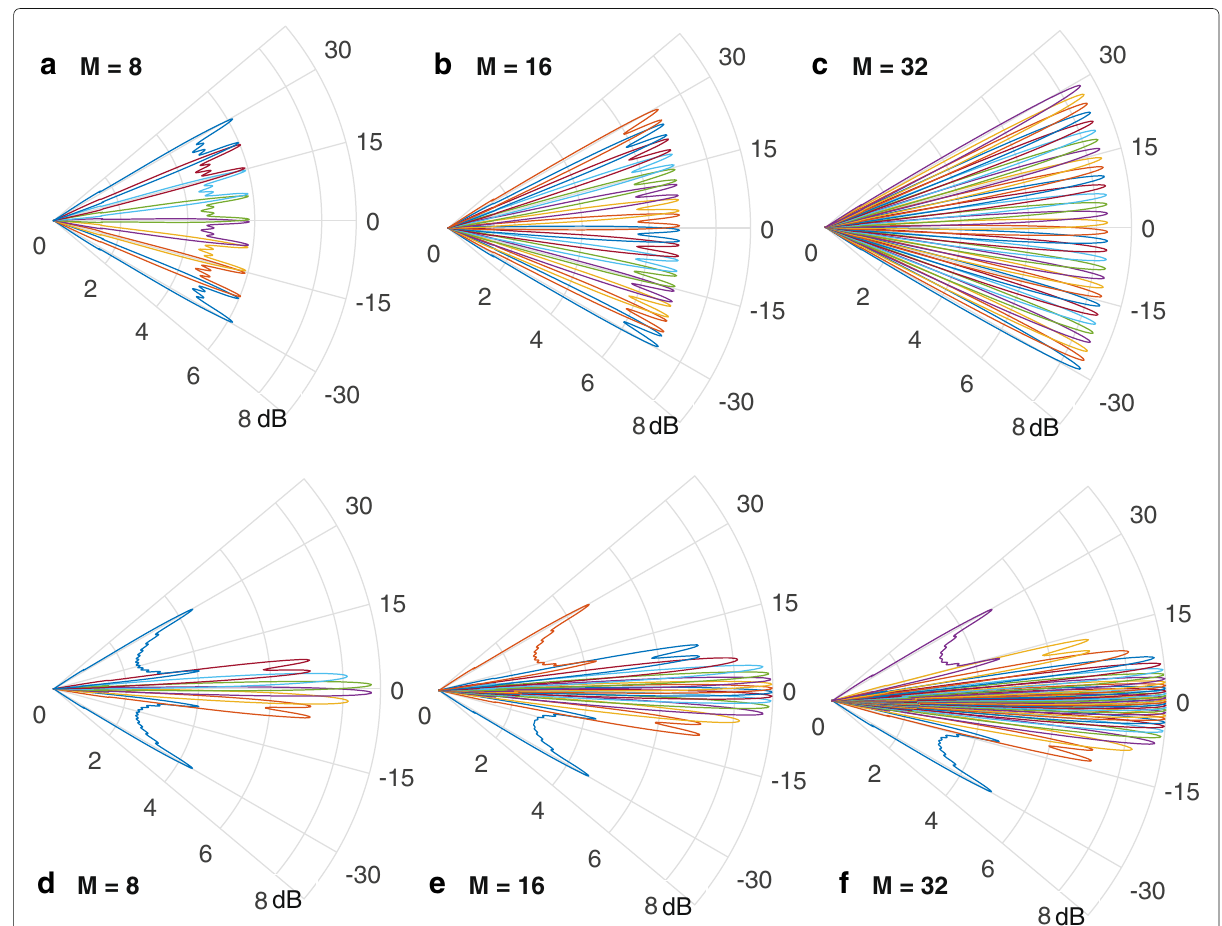
Fig. 1 Radiation patterns of the conventional uniform beam codebooks a – c and Laplacian beam codebooks d – f for N t = 64 on the angular support [ − 30 ◦ , 30 ◦ ]. For the Laplacian beams, it is assumed that m φ = 0 and standard deviation σ φ = 7